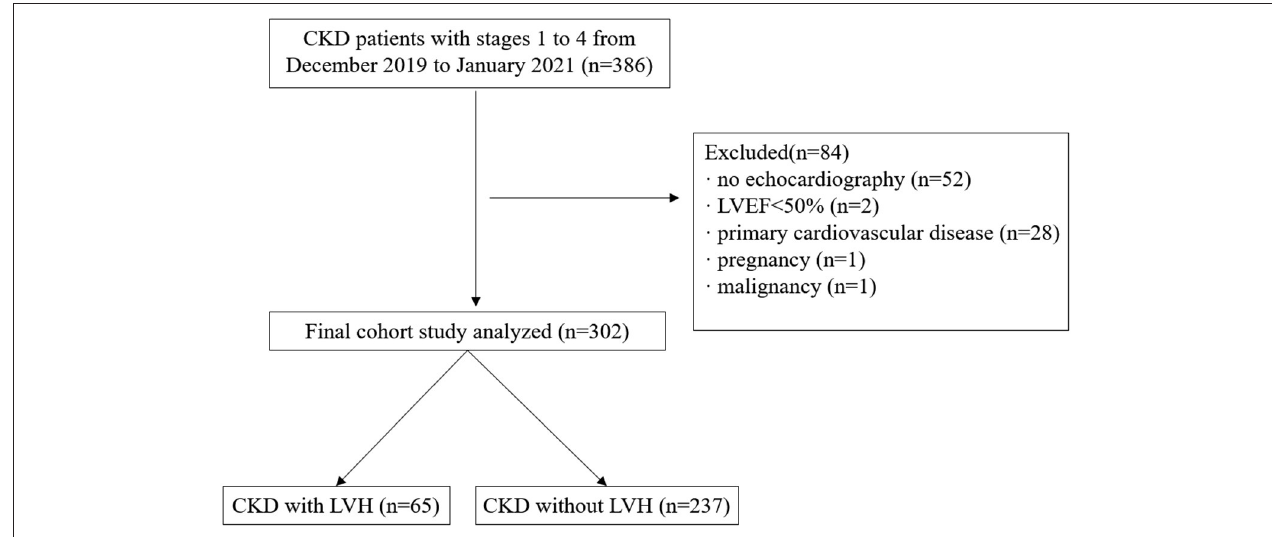
FIGURE 1 | Flowchart of study participants. CKD, chronic kidney disease; LVEF, left ventricular ejection fraction; LVH, left ventricular